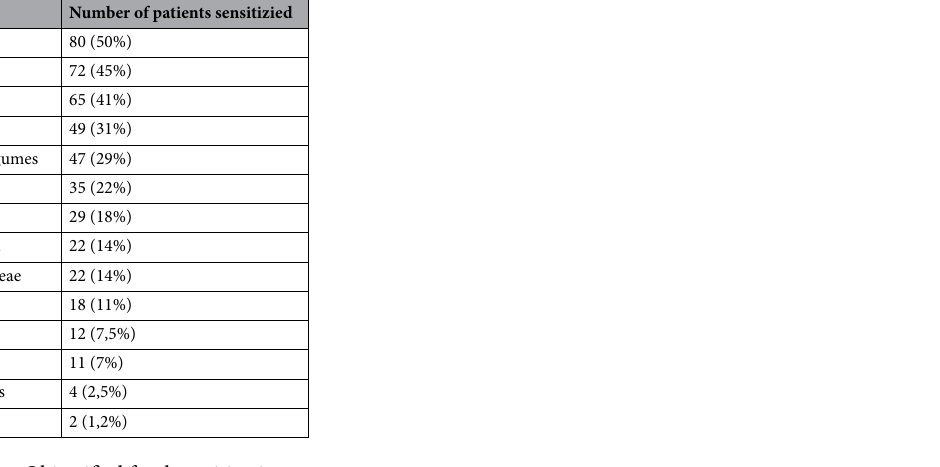
Table 2. Objectified food sensitizations.